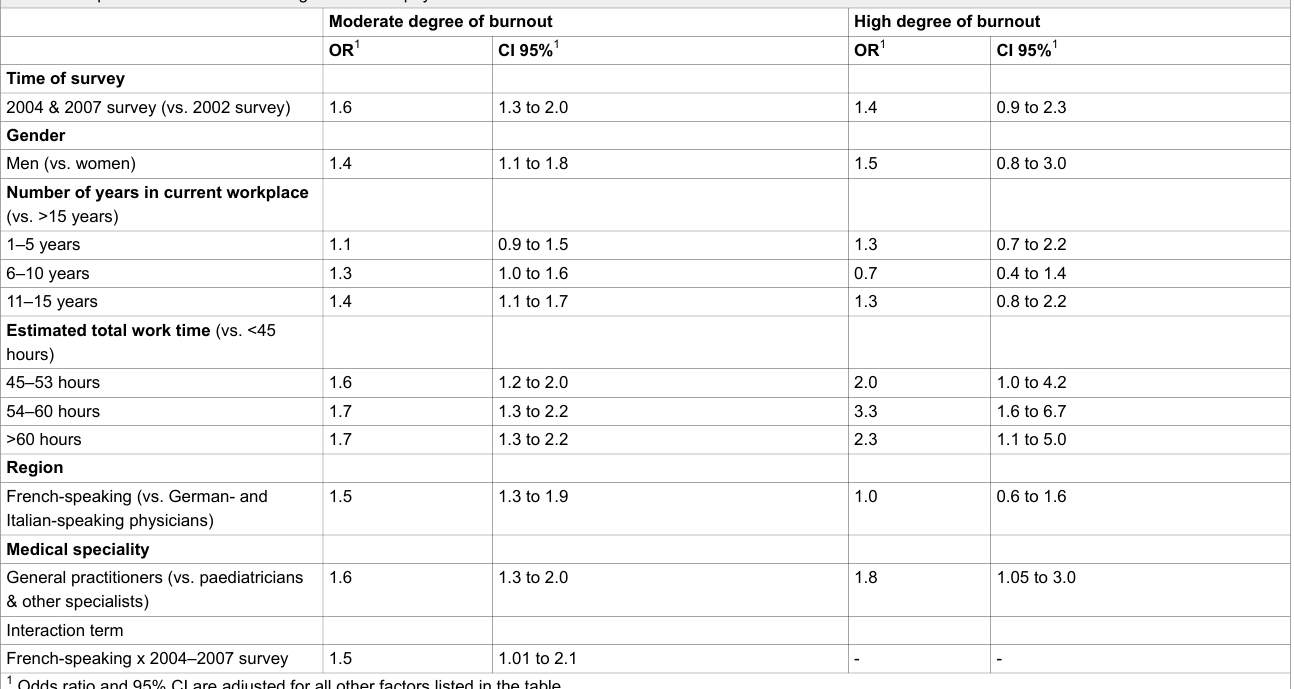
Table 4 Mutlivariate predictors of burnout among 2735 Swiss physicians.